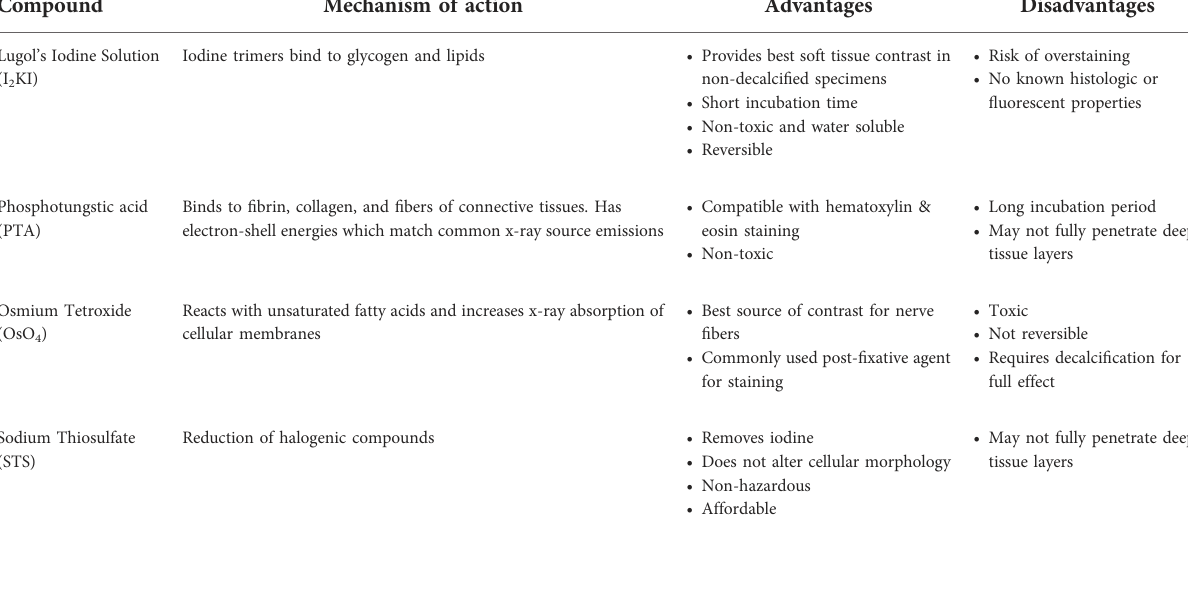
TABLE 1 Overview of properties of staining and destaining